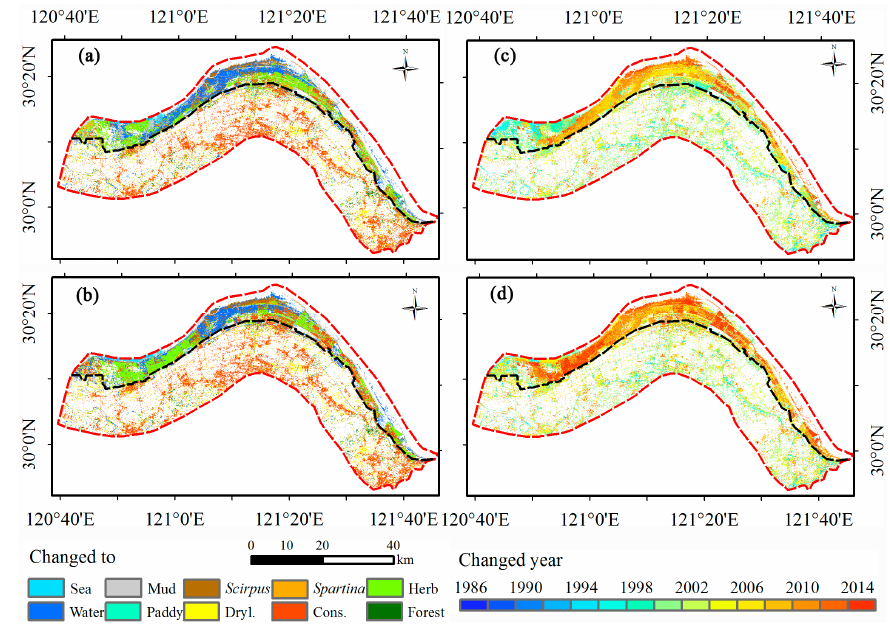
Figure 7. Land cover change directions and corresponding change years at Hangzhou Bay in Zhejiang Province, China, during 1987–2015. ( a , b ) are the earliest and latest land cover change directions, respectively; ( c , d ) are the years of the earliest and latest land cover changes, respectively. If a pixel changed only once, ( a ) is the same as ( b ), and ( c ) is the same as ( d ) (note: Dryl., dryland; Cons., construction land).